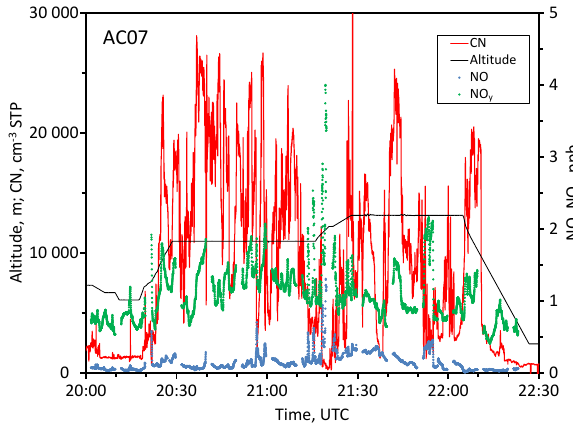
Figure 21. CN vs. CO concentrations in the upper troposphere above 8km (15s averages). Figure 22. CN, NO, and NO y concentrations in a flight segment in the upper troposphere on flight